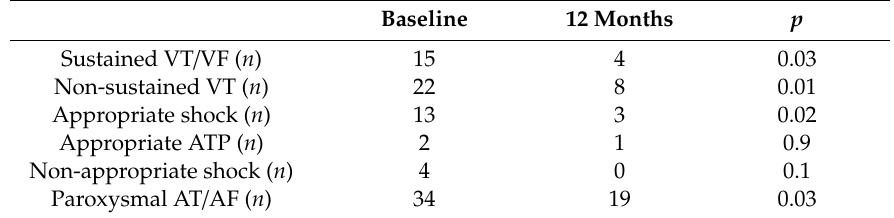
Table 6. ICD detected arrhythmias and therapies at baseline and over time in the overall study